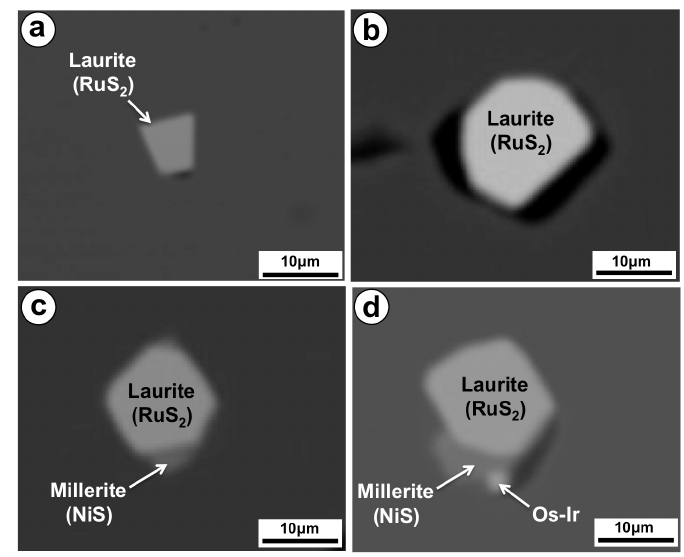
Figure 4. (a – d) Backscattered electron images of platinum-group mineral grains and associated millerite in unaltered chromite grains of the North Andaman chromitites. Grains of laurite are Os-poor [(Ru 0.66 Os 0.21 Ir 0.08 Rh 0.01 Fe 0.03 Ni 0.01 ) ∑=1.00 S 2.00 ] similar to other laurite